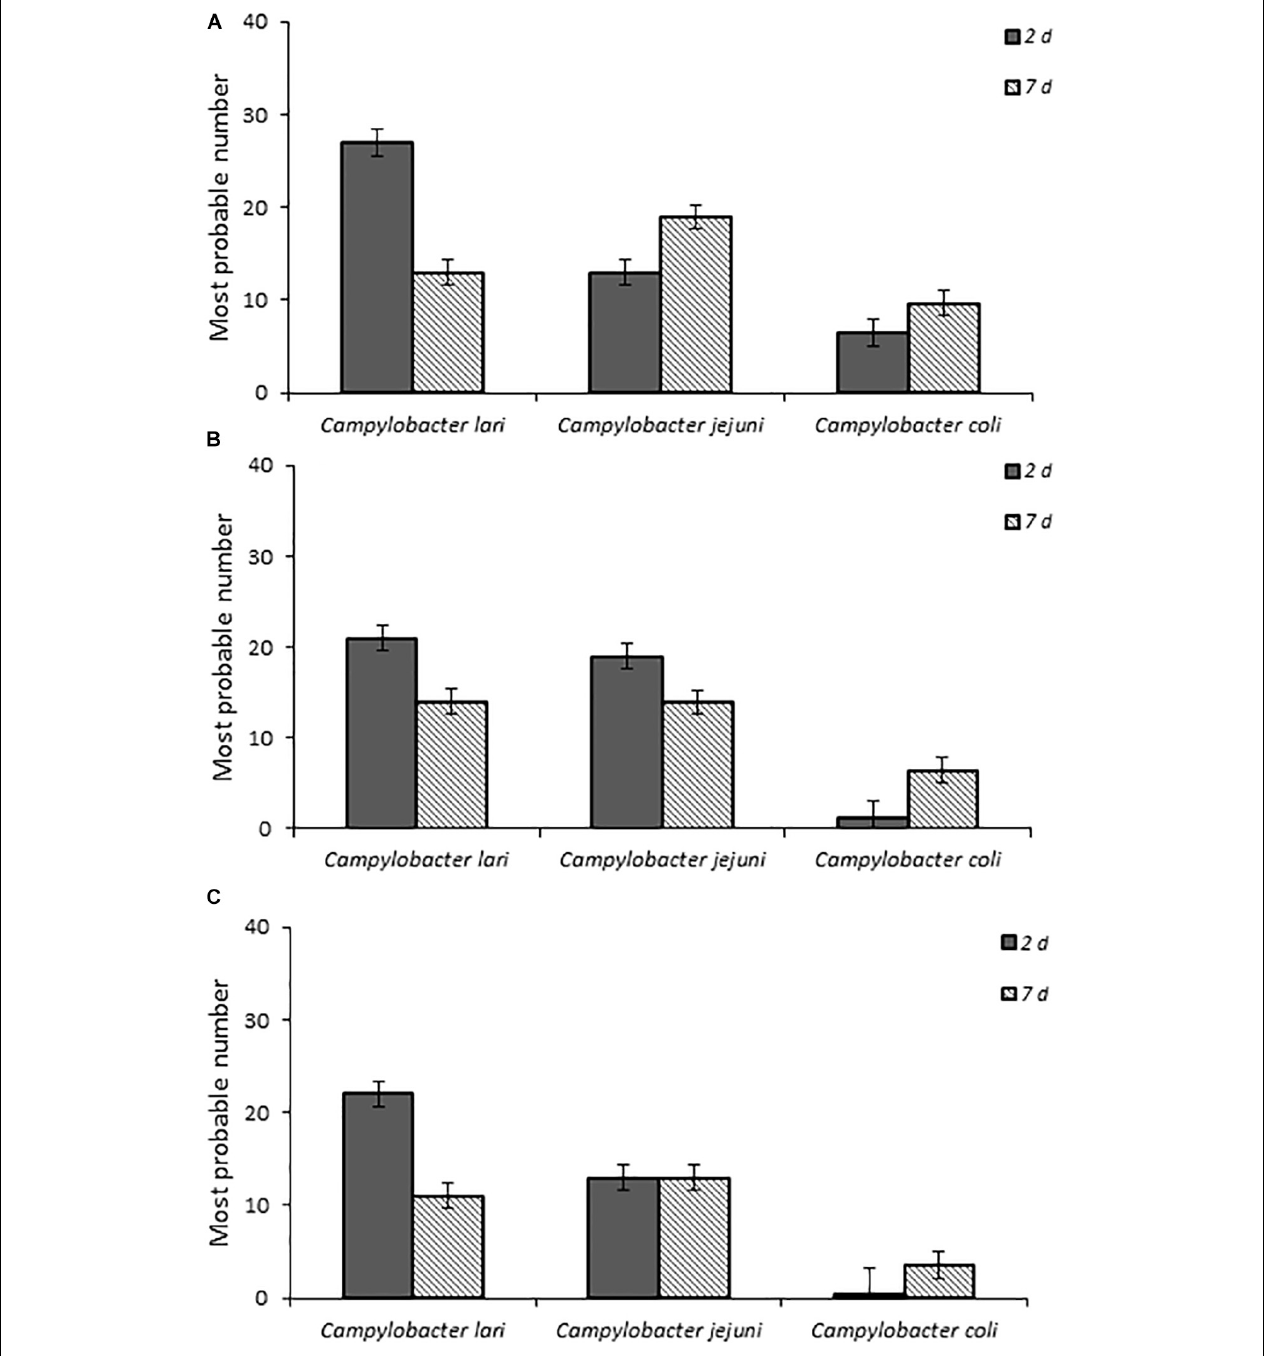
FIGURE 2 | Fecal bacterial burden in infected chicks with Campylobacter spp. laboratory isolates at doses (A–C) , respectively, as determined by the most probable number (MPN) calculations as described in section “Materials and Methods” and in Supplementary Table S1 .